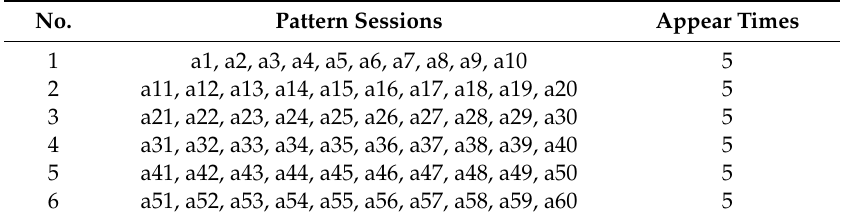
Table 5. The pattern sessions should be discovered by system.